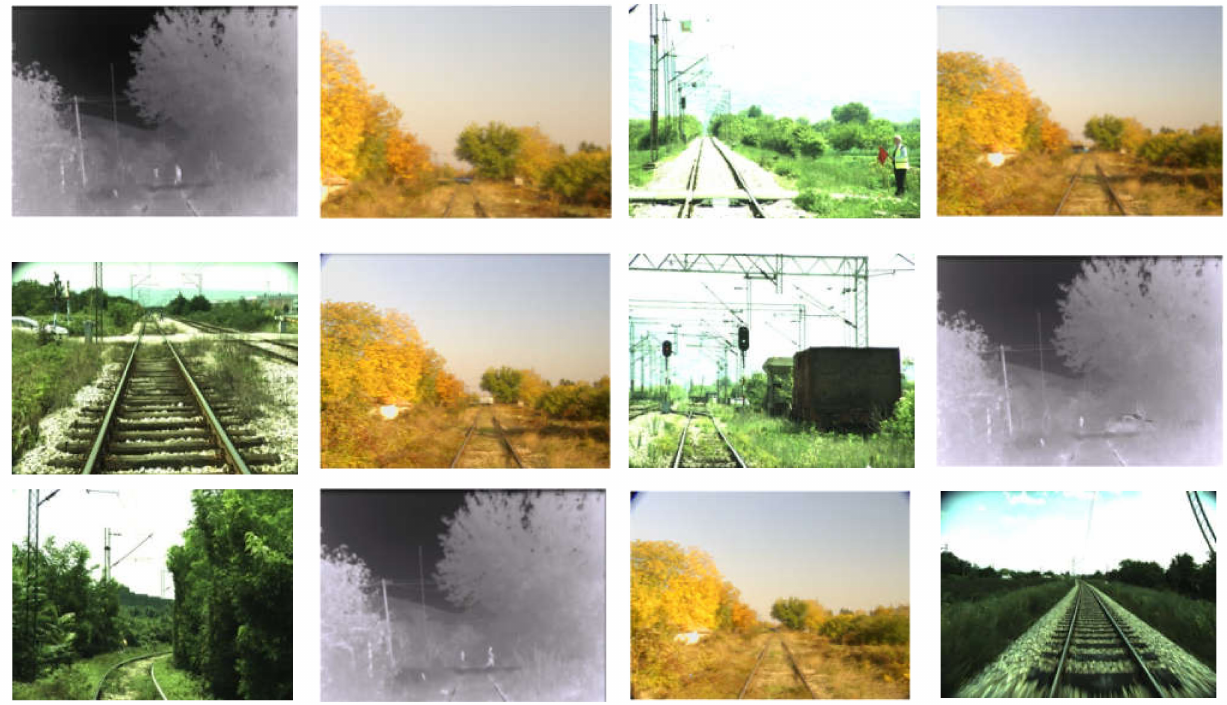
Figure 6. Selected examples of images in our railway